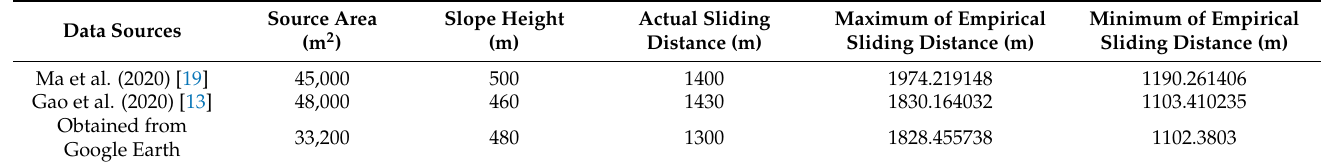
Table 1. Comparison of the sliding distance obtained by empirical formula and the actual sliding